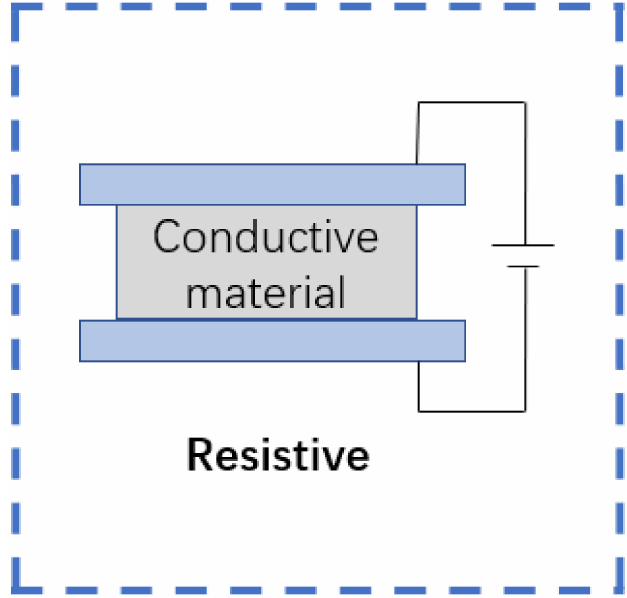
Figure 3. Diagram of the signal conversion mechanism of a resistive flexible